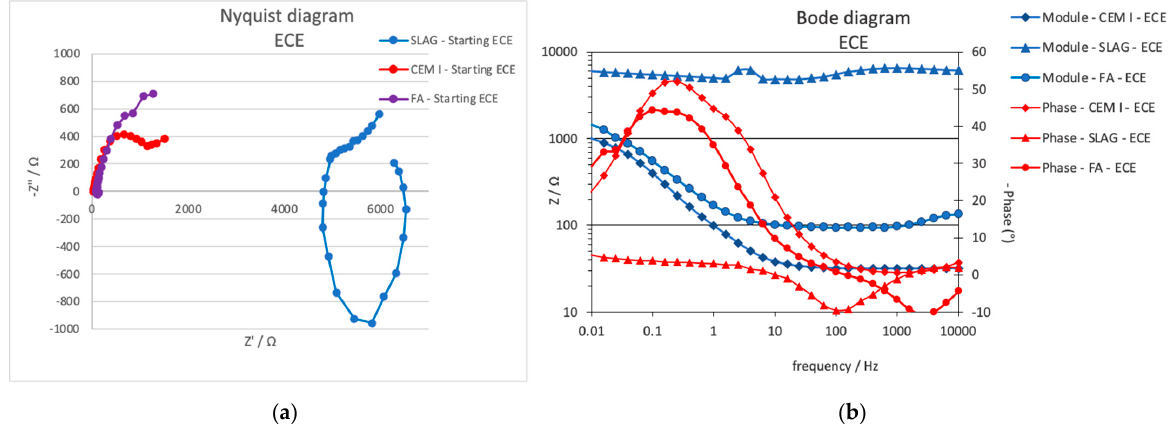
Figure 6. (a) Nyquist and ( b ) Bode diagrams obtained in the three mortar specimens in the first phase of the ECE treatment using the central rebar as working electrode, where Z is the impedance vector module and Z’ Z’’ the real and the imaginary components.